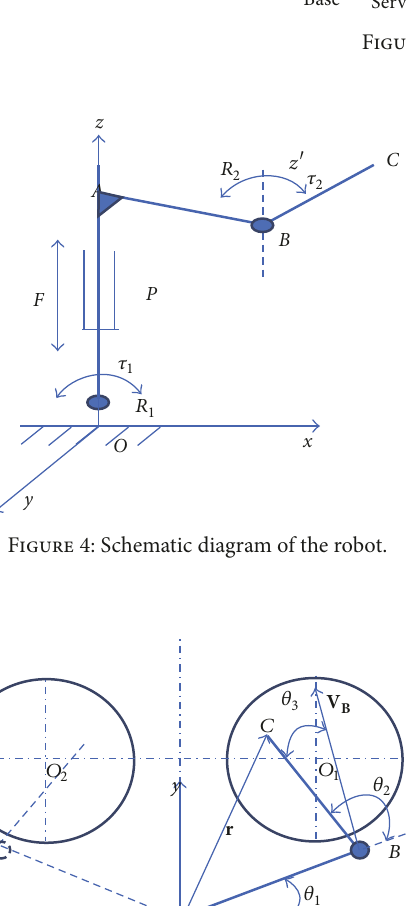
symmetrically distributed about 𝑦 -axis. According to these geometric relationships, closed-loop position equation of the robot can be expressed as